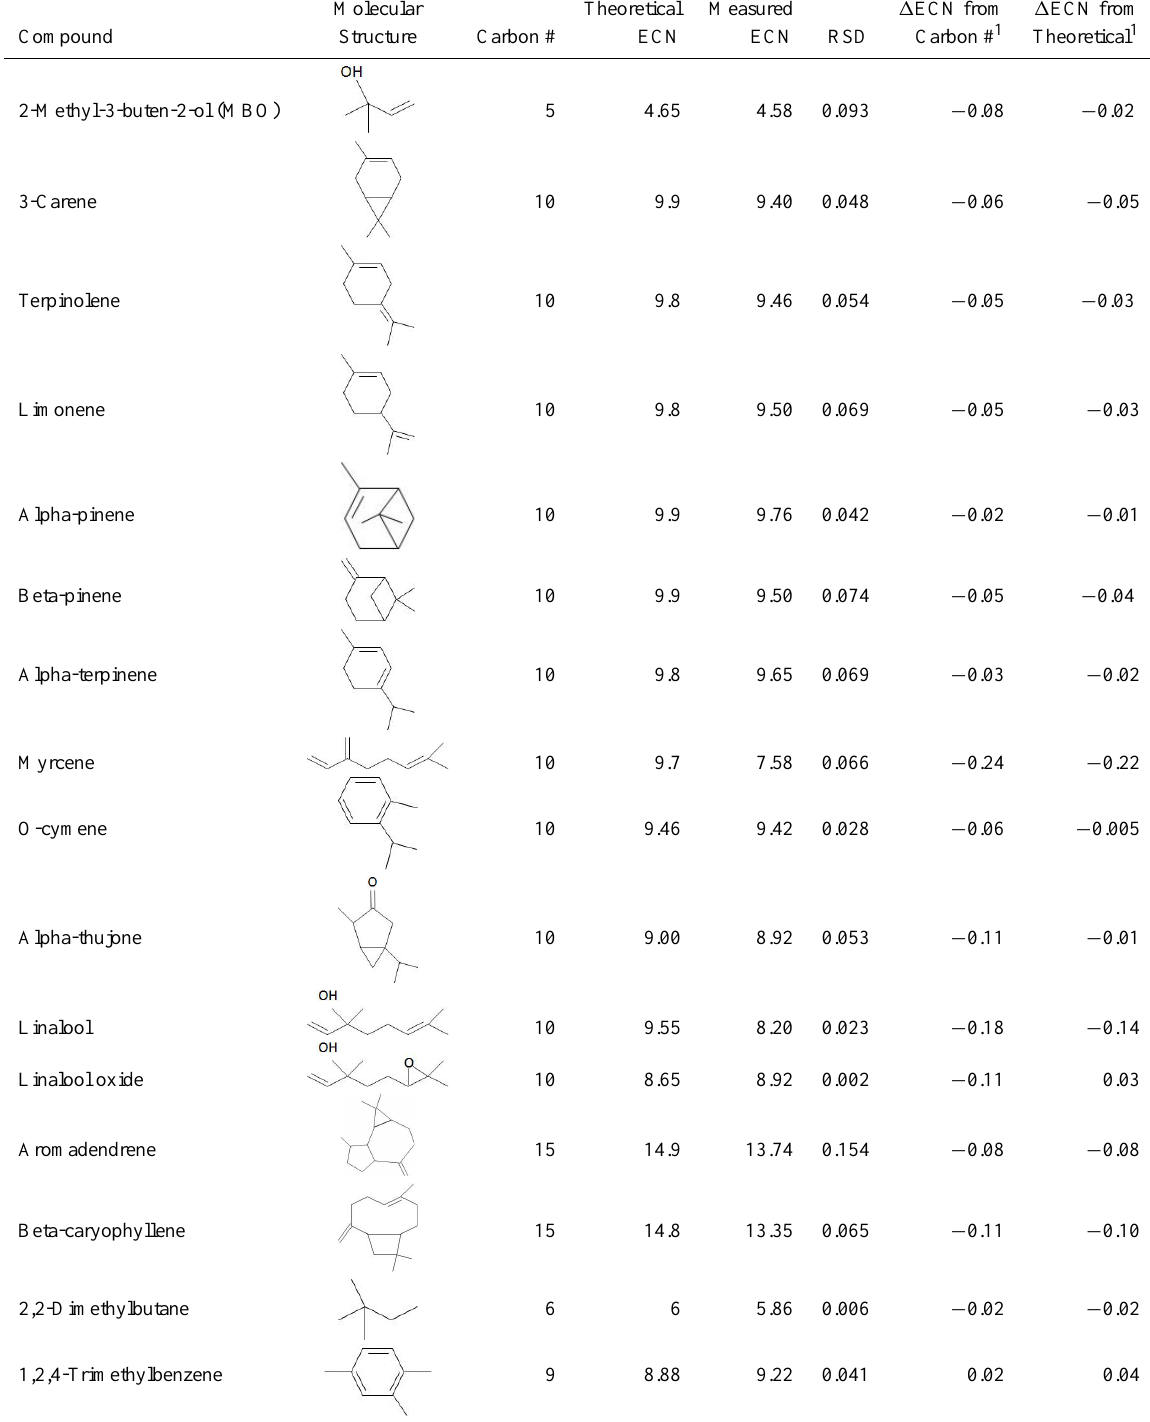
Table 4. Summary of study results.